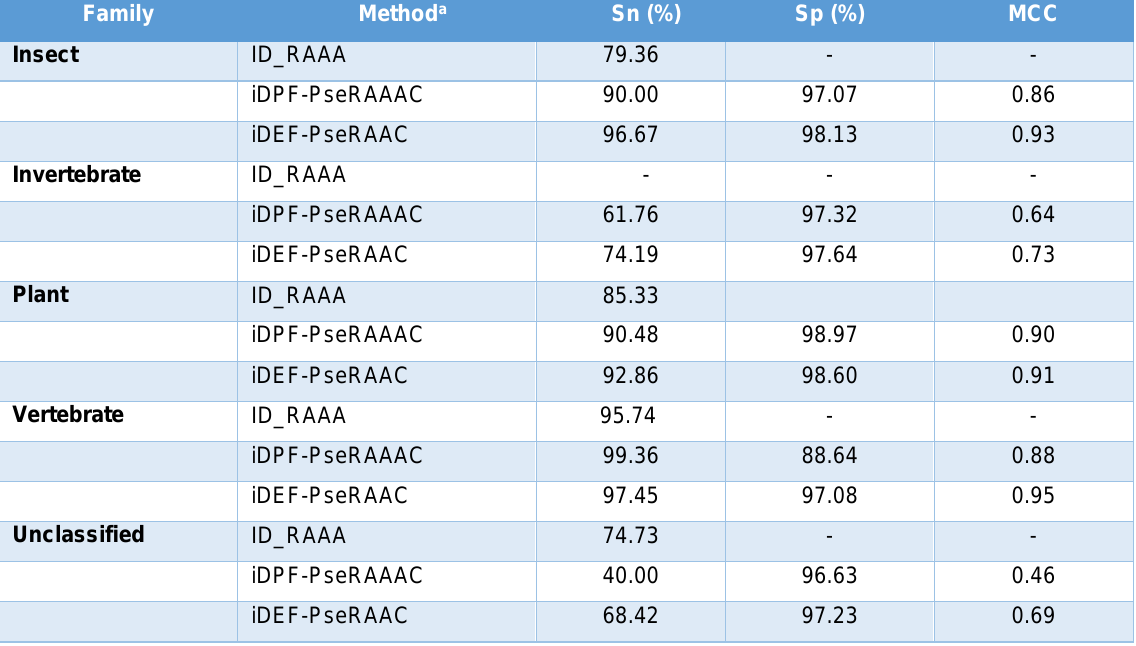
Table 4: Performance comparison of ID_RAAA, iDPF-PseRAAAC and iDEF-PseRAAC for the predic- tion of defensins